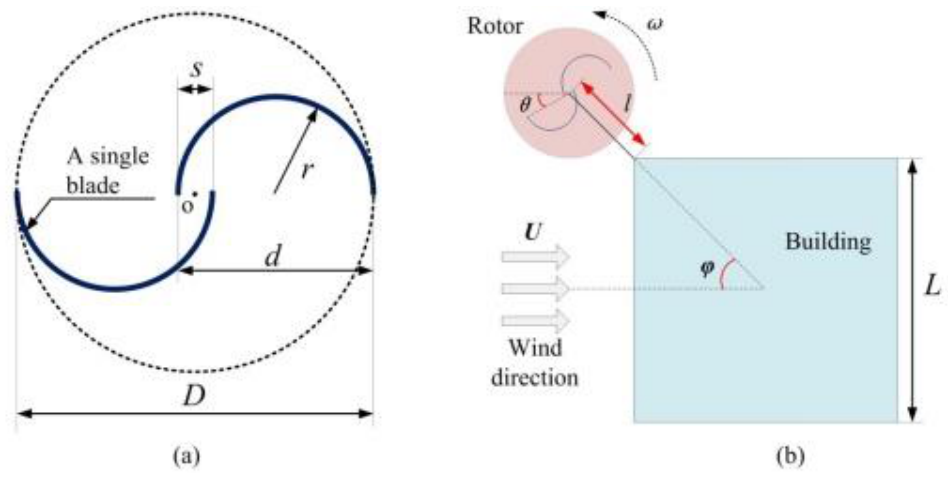
Figure 2. Parameters of the Savonius turbine (the rotor and the building are not scaled). ( a ) Structural parameters of the Savonius rotor; ( b ) operational parameters of the Savonis rotor.